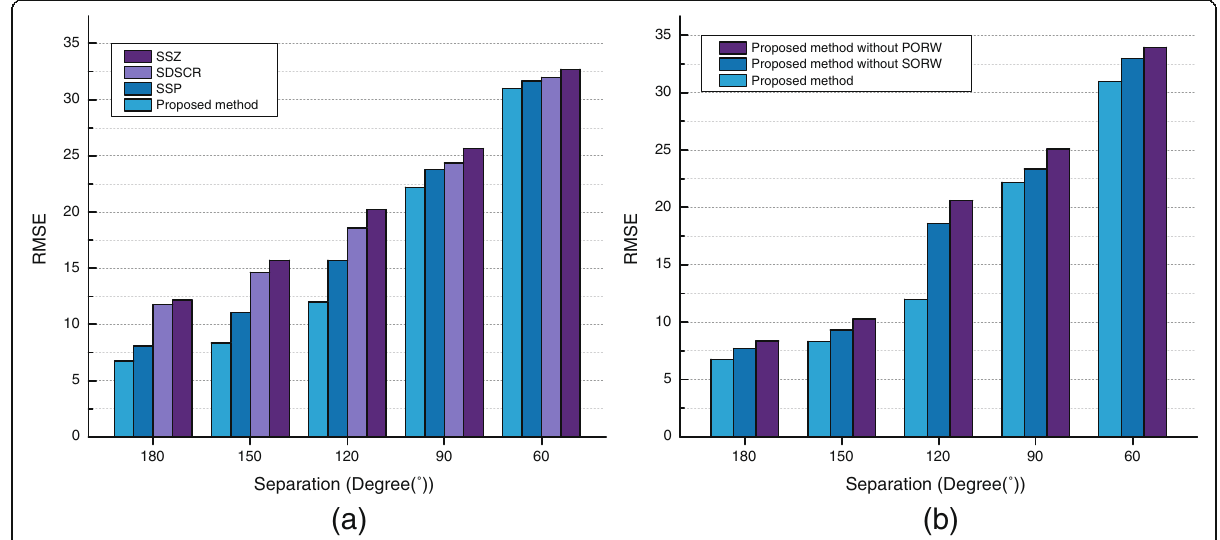
Fig. 12 RMSE of localization results by using actual recorded signals, two sources. a The RMSE of localization results using different methods. b The RMSE of localization results using different proposed